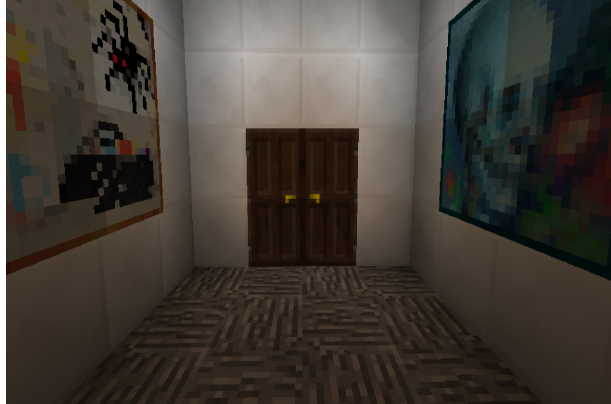
Figure 4 - Students game design settings, which involves an investigation mystery about genetics